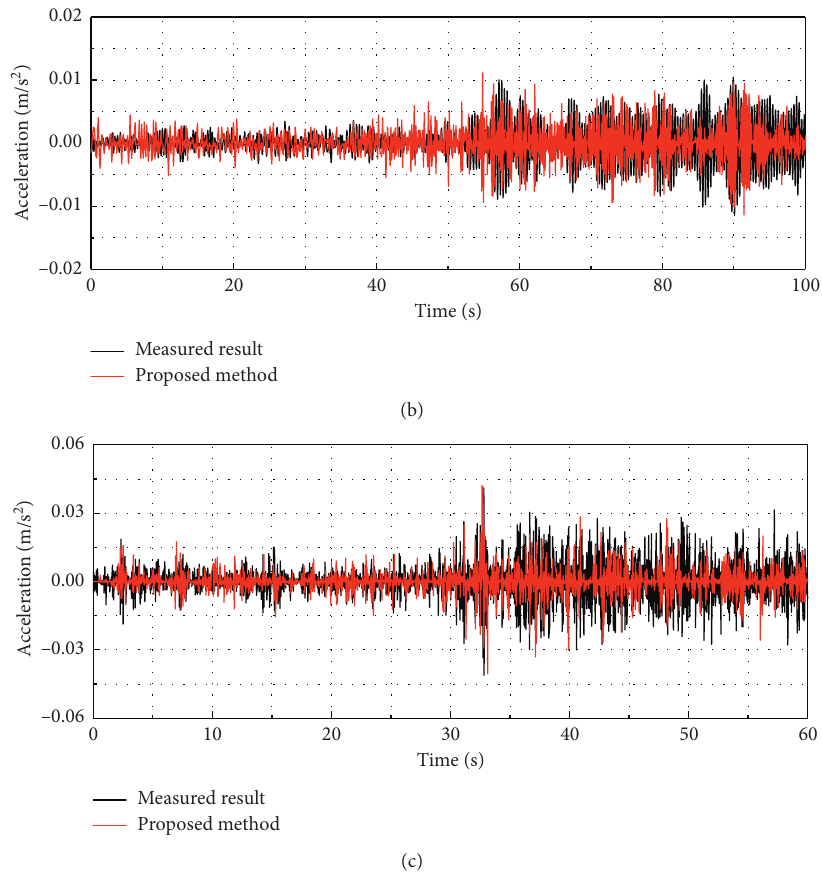
Figure 11: The comparison of midspan acceleration results. (a) Under 20km/h; (b) under 30km/h; (c) under 50km/h.